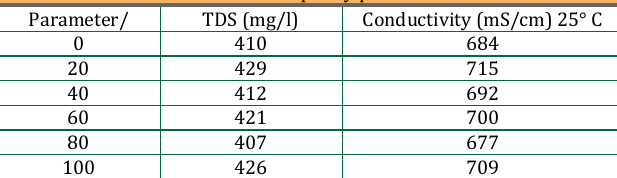
Table 4: Water quality